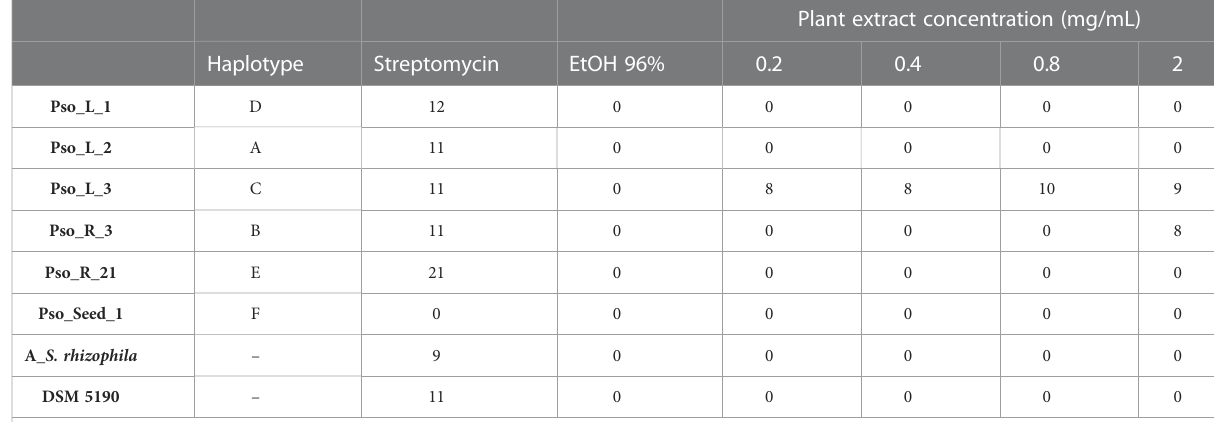
TABLE 6 The measure of the halo diameter (mm) produced by the lack of growth of the bacterial strains in the presence of different concentrations of the tested plant